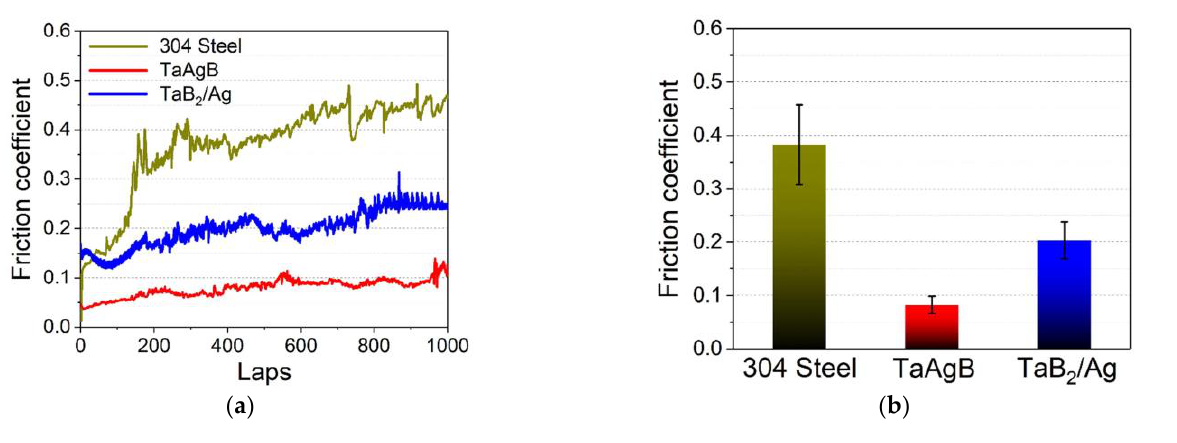
Figure 3. ( a ) Dynamic friction curves for TaAgB coating, TaB 2 /Ag coating, and uncoated 304 steel. ( b ) Mean friction coefficient for TaAgB coating, TaB 2 /Ag coating, and uncoated 304 steel. TaB 2 : tantalum boride. Adapted with permission from [68]. Copyright 2022, Elsevier.